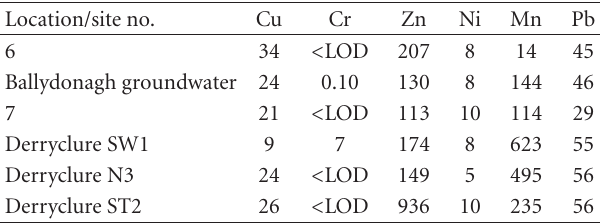
Table 9: Concentrations in landfill leachate µ g/L – April. Location/site